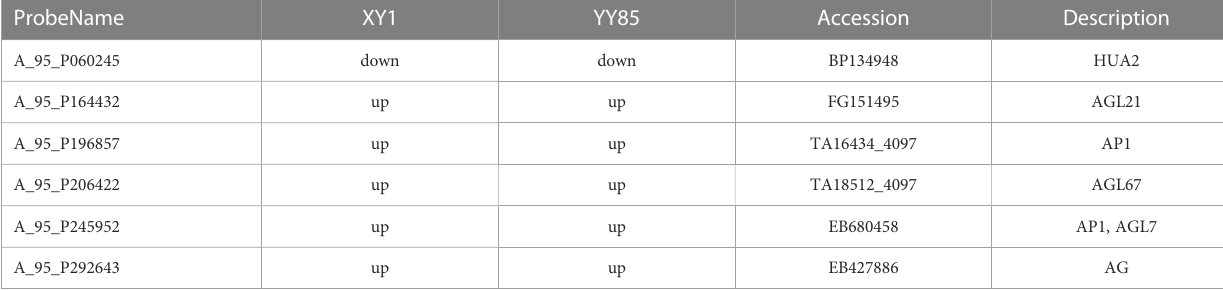
TABLE 1 The differential expression of fl owering pathway genes in tobacco under cold stress.